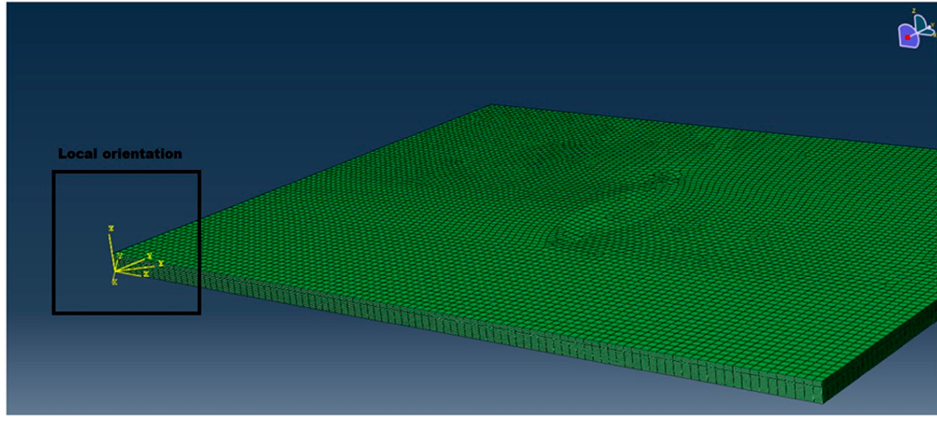
Figure 7. An overview of the mesh and of the local orientation of each ply.